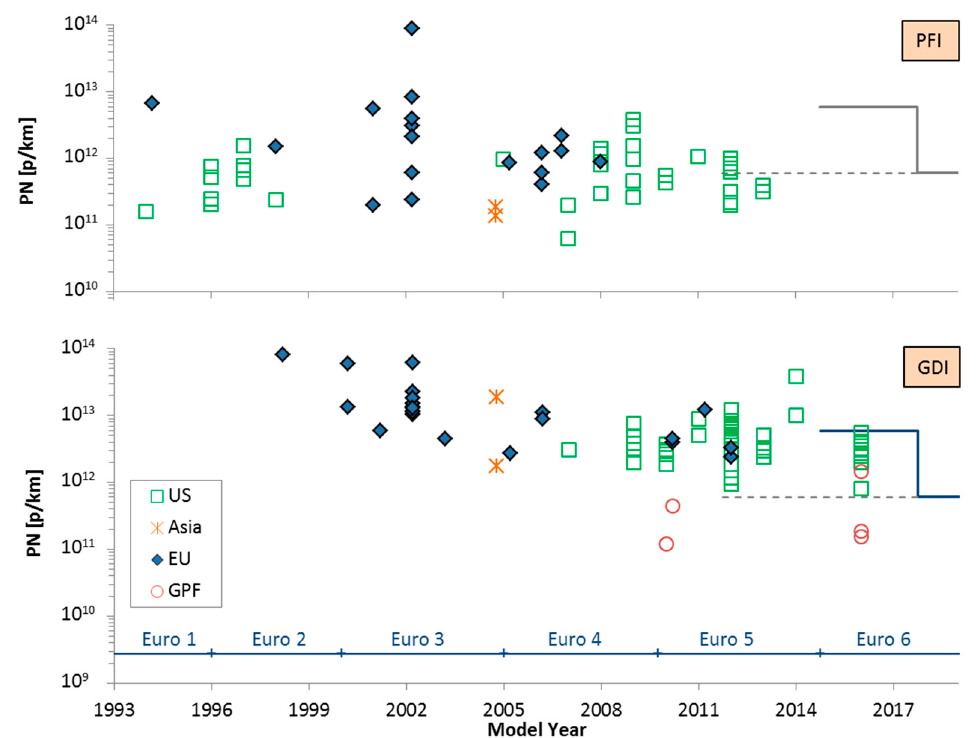
Figure A1. Total particle number (PN) emissions for gasoline direct injection (GDI) (lower panel) and port fuel injection (PFI) (upper panel) vehicles. Dashed line shows solid PN (SPN) limit for diesel vehicles (only EU). Solid line shows SPN limits for GDI vehicles (only EU).